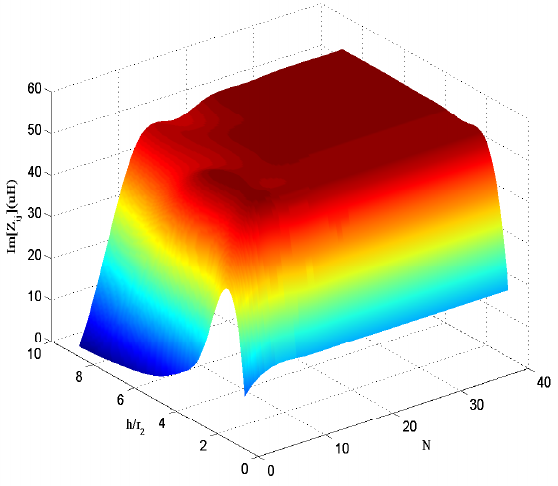
Figure 4. The influence of N and h on the imaginary part of mutual